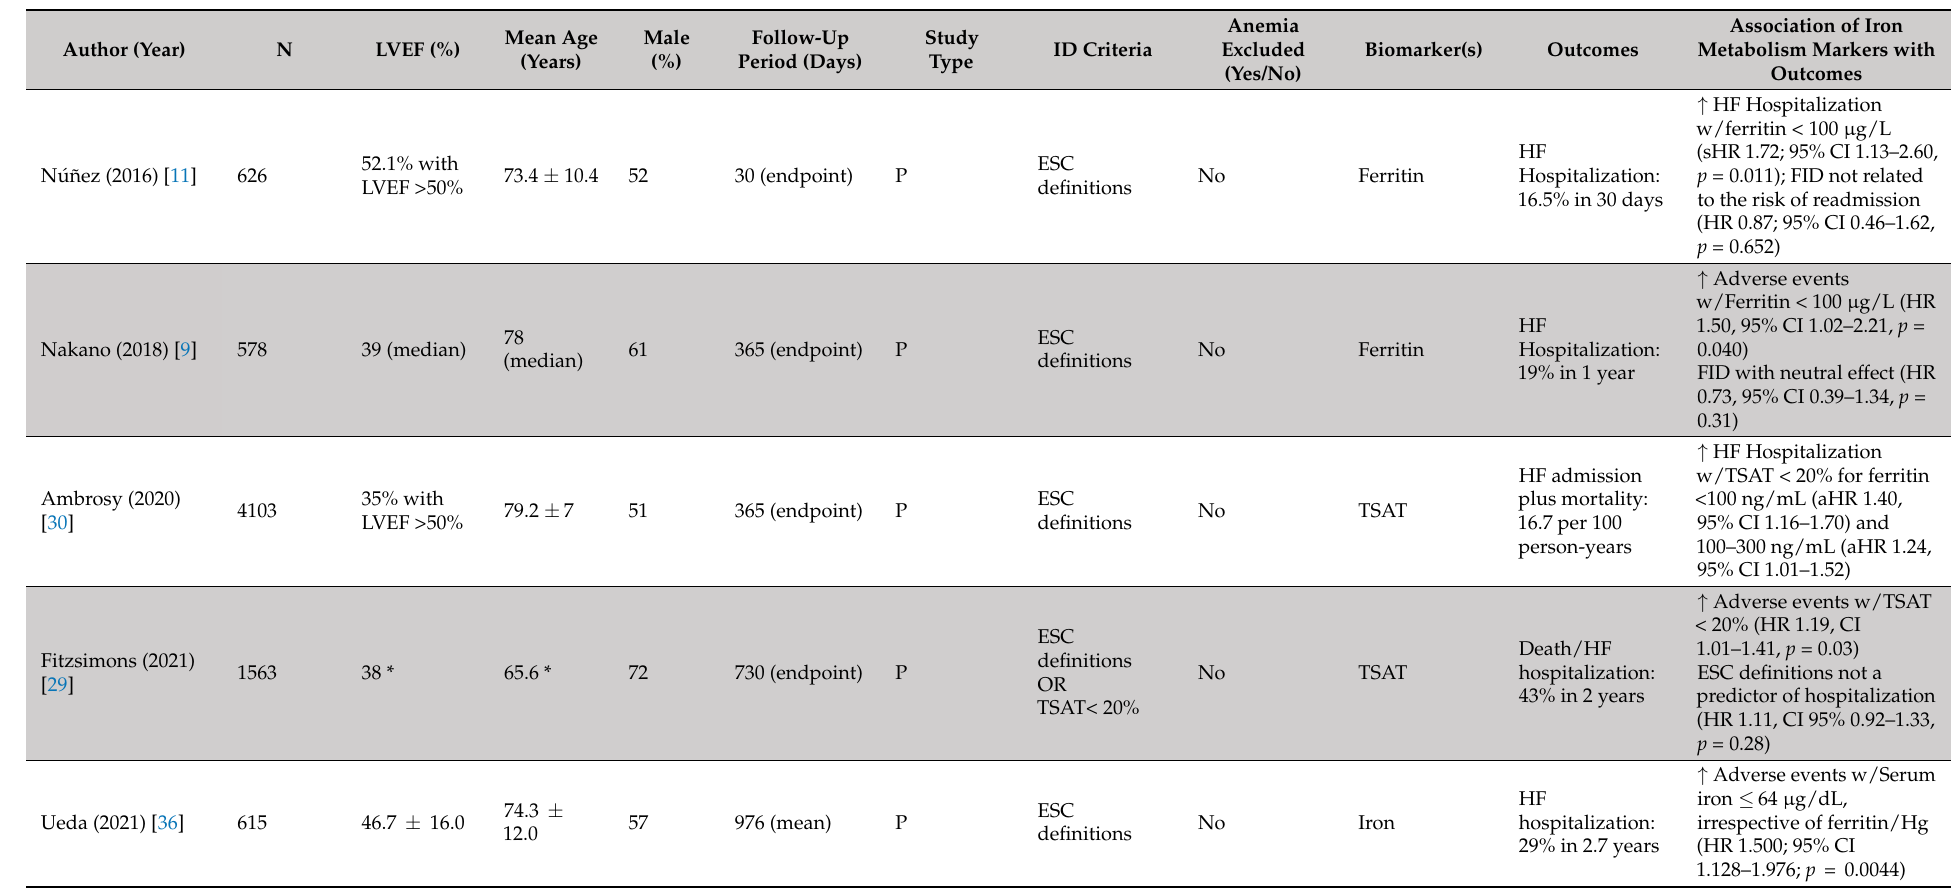
Table 2. Characteristics of Studies Associating Biomarkers of Iron Metabolism with Heart Failure